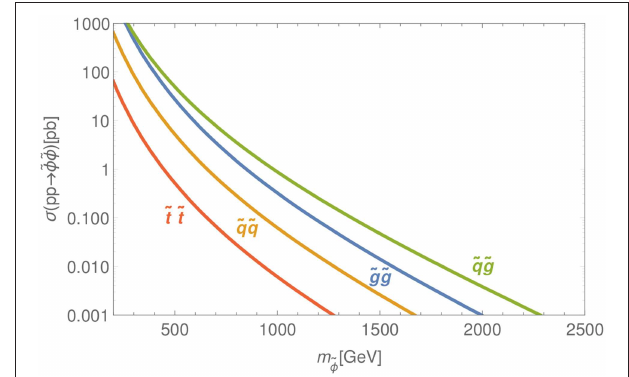
FIGURE 9 | Pair production cross sections as a function of the mass of sparticle ˜ φ at center of mass energy √ s